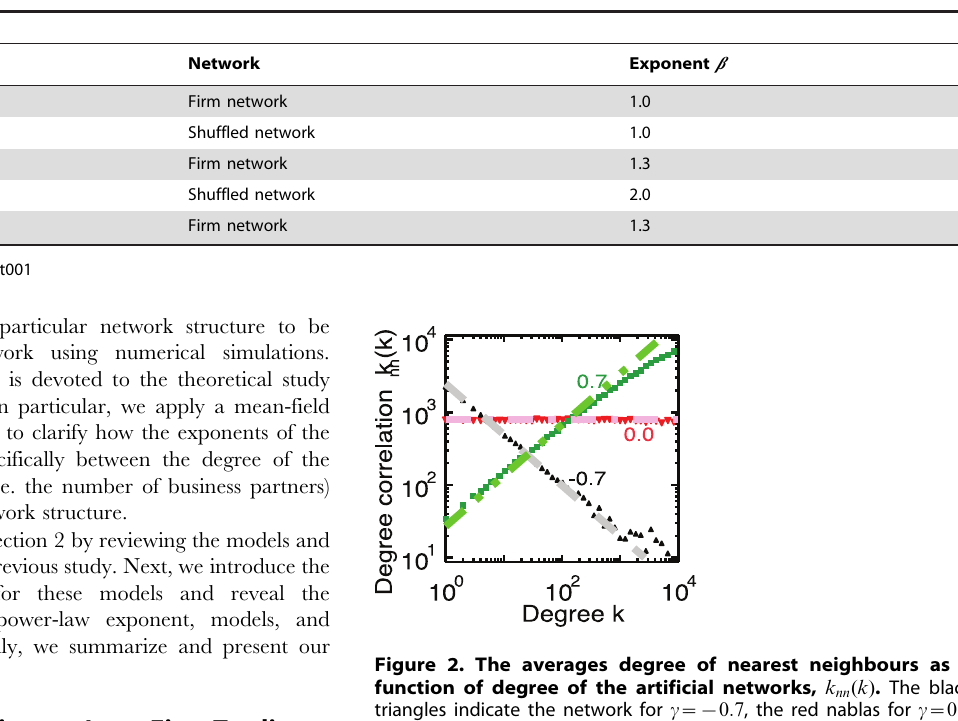
Table 1. Summary of exponents.